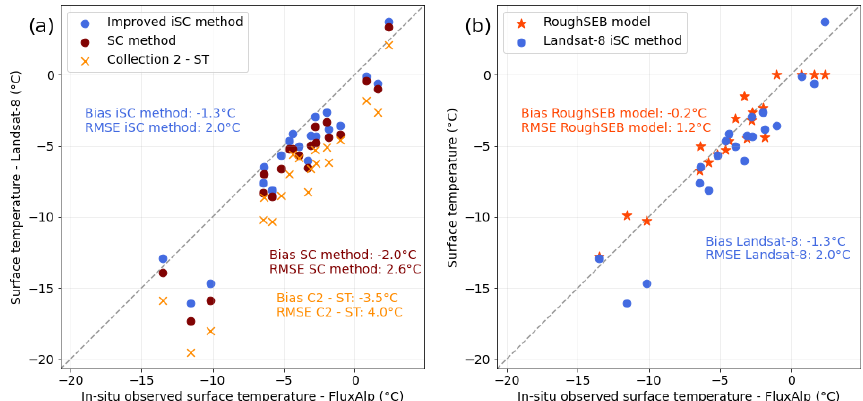
Figure 5. Landsat-8-retrieved surface temperature as a function of surface temperature measurements at the FluxAlp station (a) using the iSC method (blue) and the SC method (brown). The Collection 2 surface temperature product is shown in orange. (b) Simulated T s by the model (red) and observed T s by Landsat 8 (iSC method, blue). The 1 : 1 dashed line represents perfect agreement with in situ